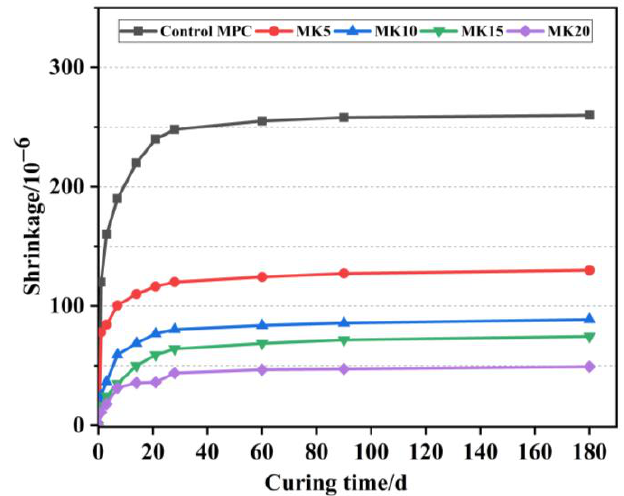
Figure 19. Effect of MK on MPC drying shrinkage deformation.